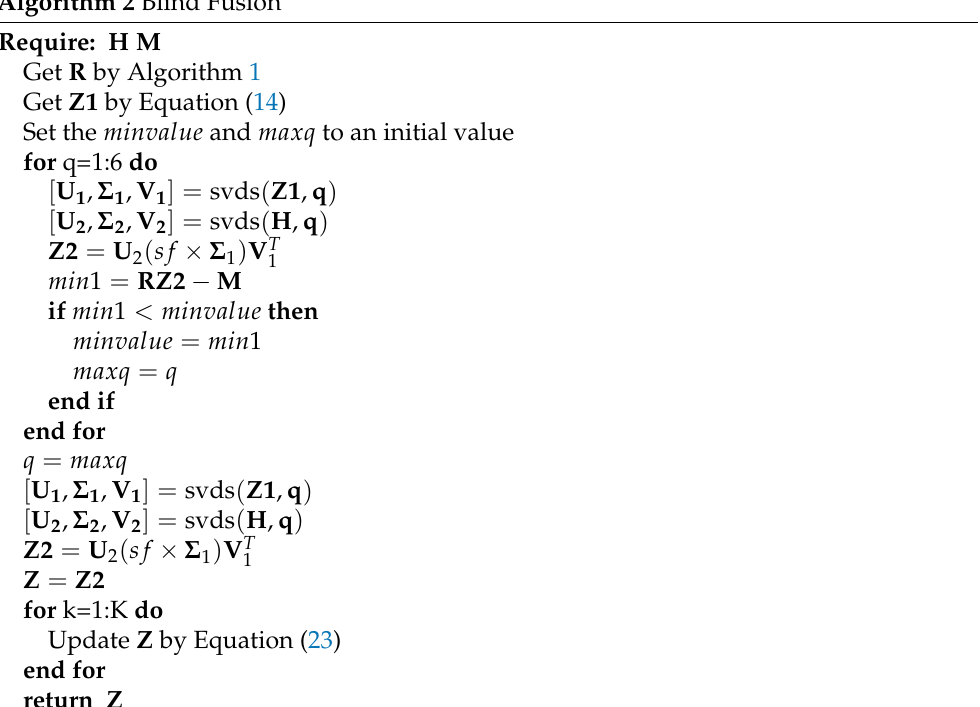
Algorithm 2 Blind